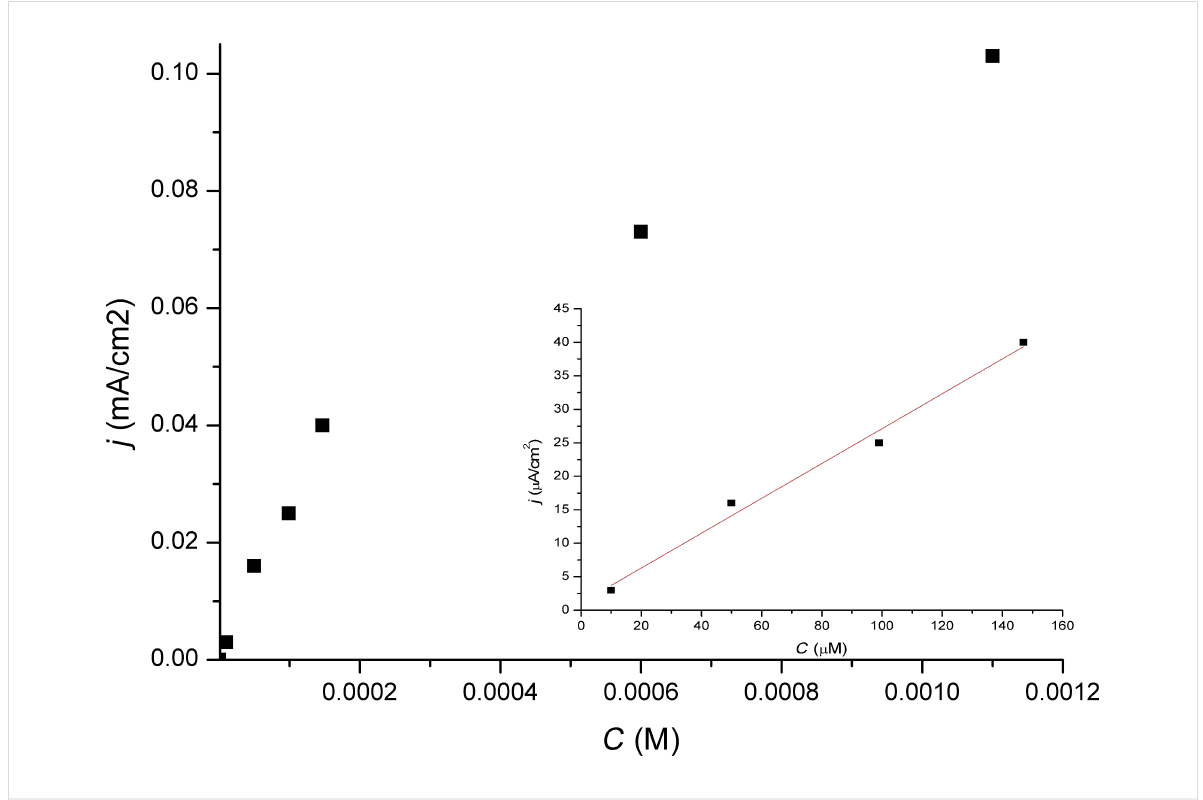
Figure 3: Standard addition curve for hydrogen peroxide recorded at 0 mV vs Ag/AgCl at a platinum UME (diam. of 25 µm) covered with three bilayers of PB–Ni–HCFs.